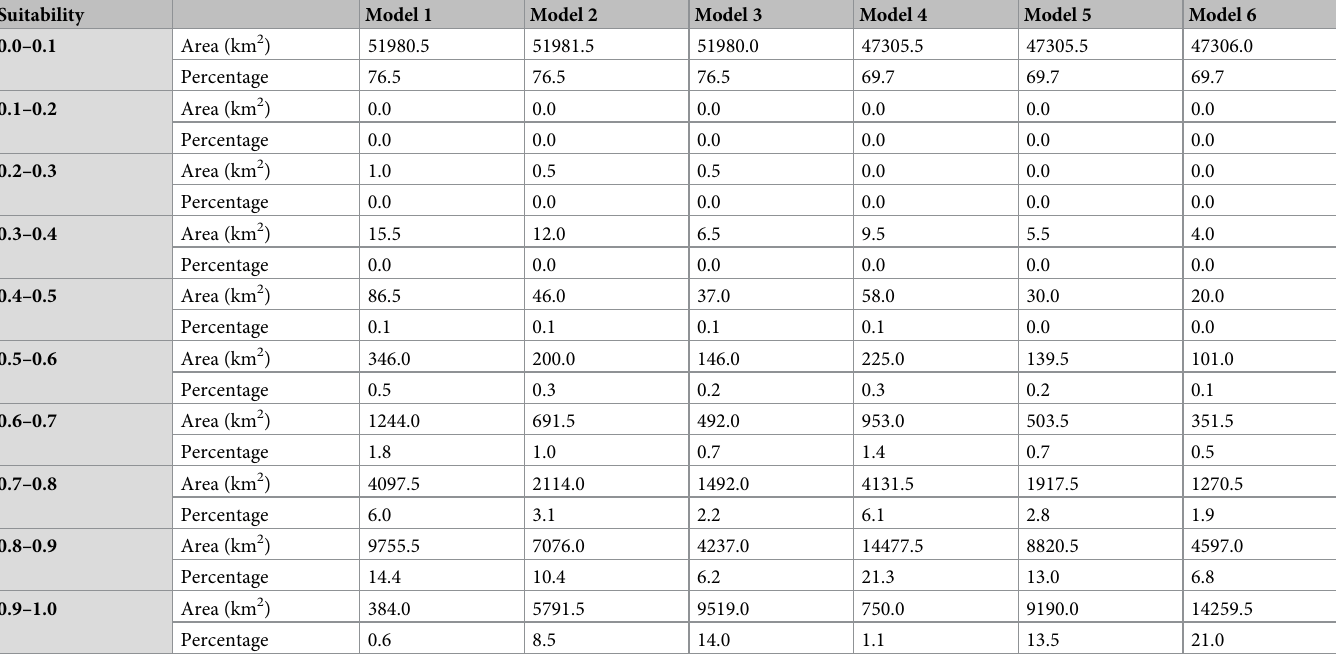
Table 5. Area of Scotland by suitability class.